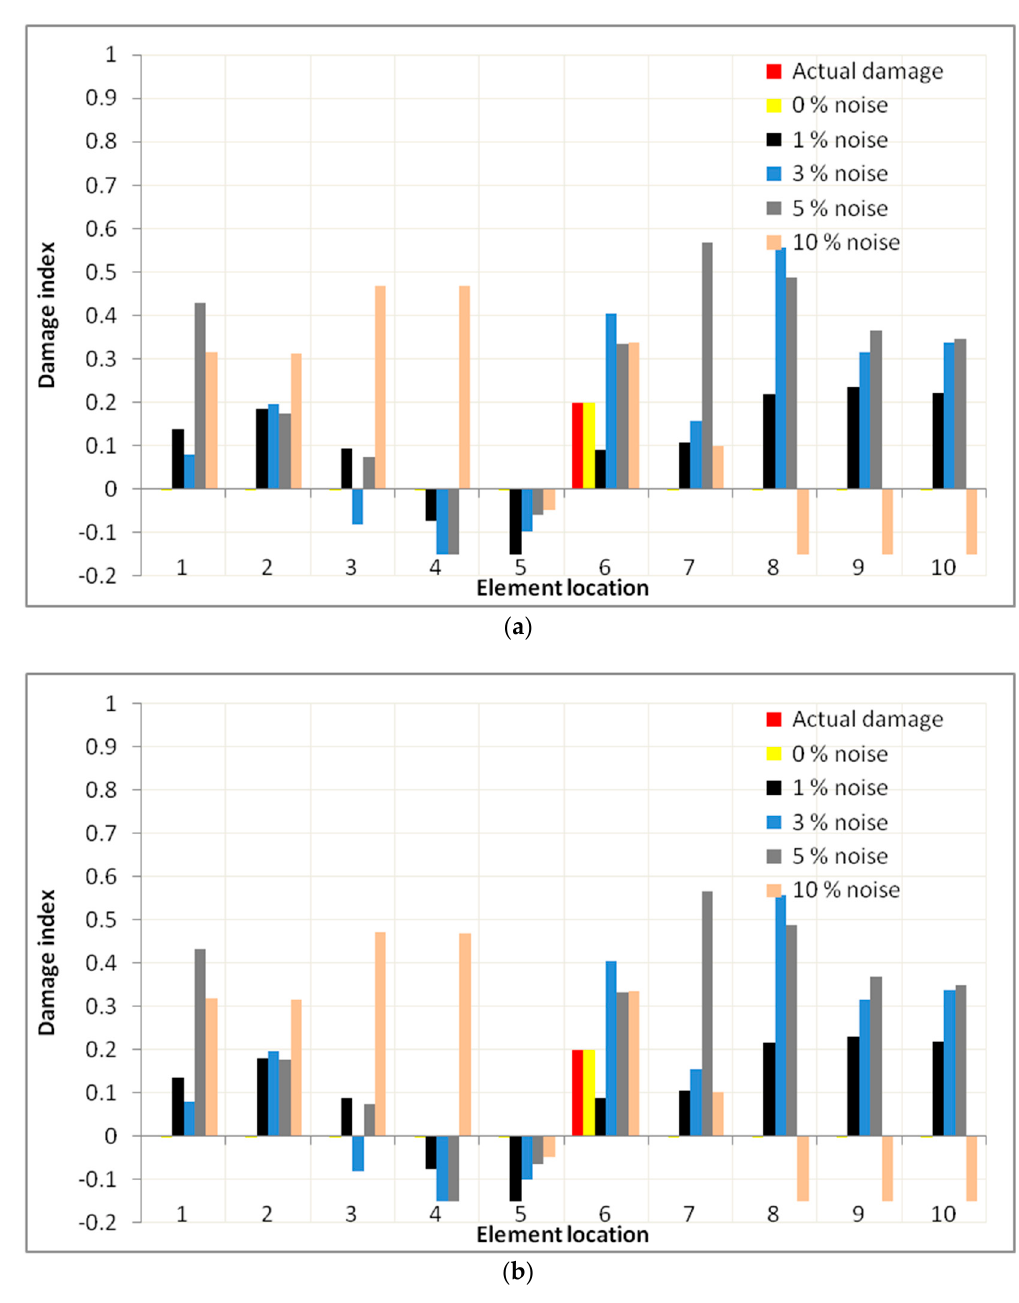
Figure 3. Damage distribution for Case 1 using Objective Function II for ( a ) noise both in frequency and mode shapes and ( b ) noise in mode shapes only.